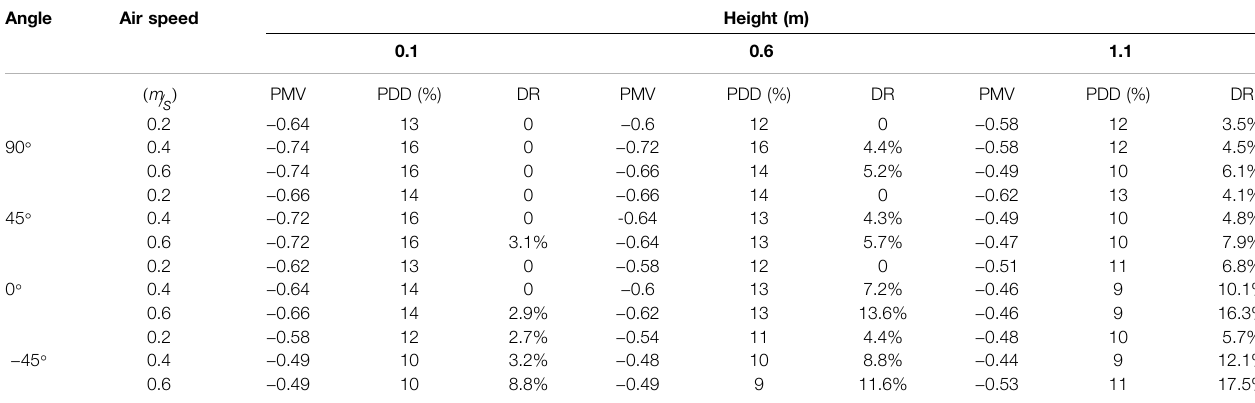
TABLE 3 | Thermal comfort evaluation at different air supply angles and air speeds.